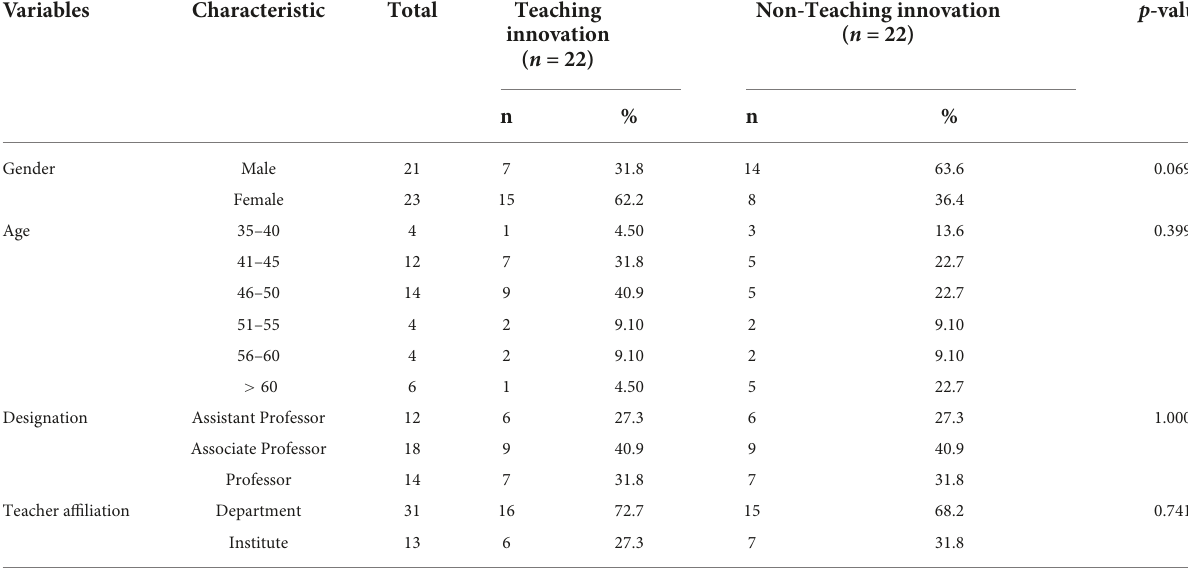
TABLE 1 Sample characteristics for the teaching innovation and non-teaching innovation groups.